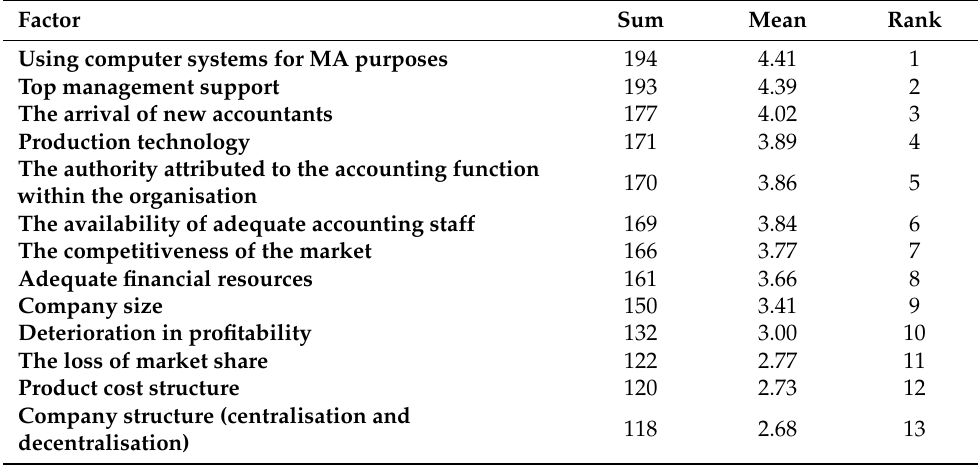
Table 8. Contingency factors facilitating the adoption of MAIs in the manufacturing sector. Factor Sum Mean Rank Using computer systems for MA